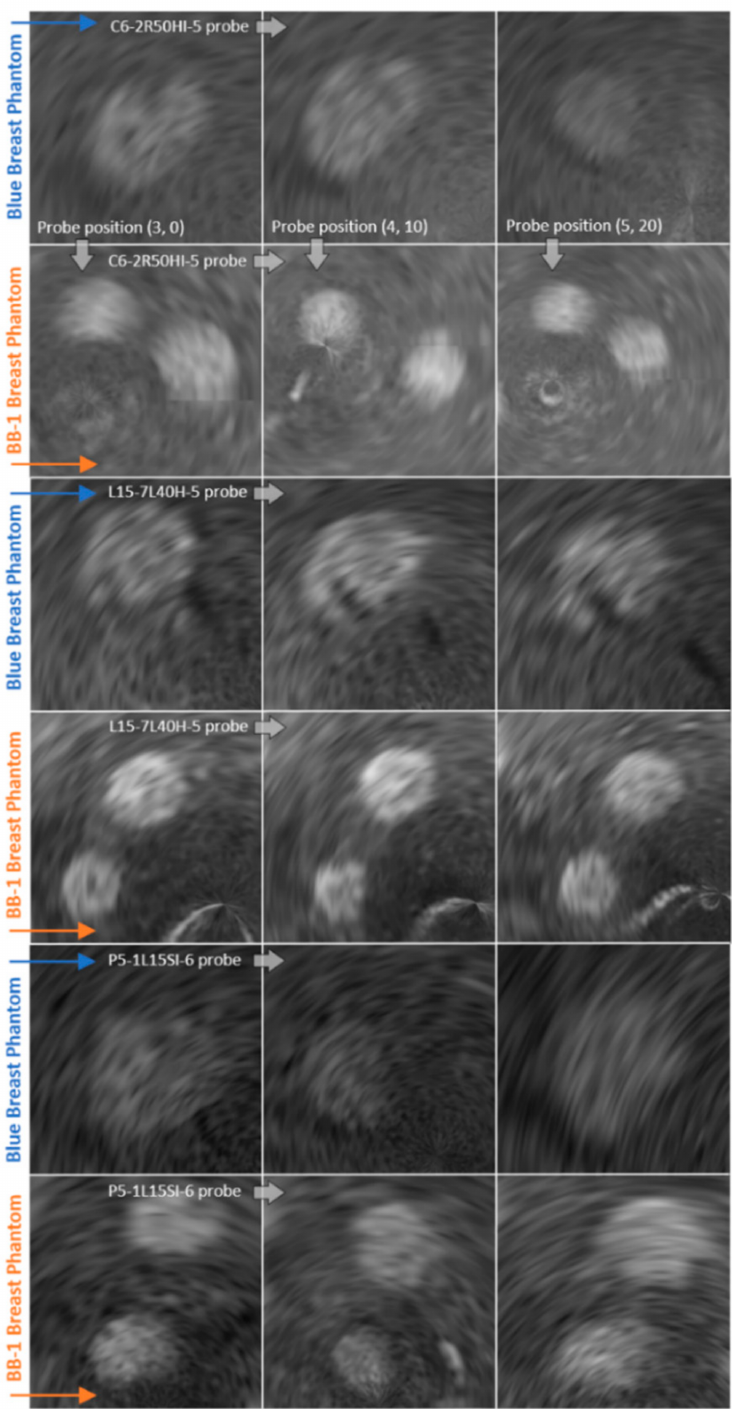
Figure 11. ROIs under evaluation acquired with 3 different types of probe (rows) in 3 different positions (columns) relative to 2 measured breast phantoms: Blue and BB-1, as indicated along the